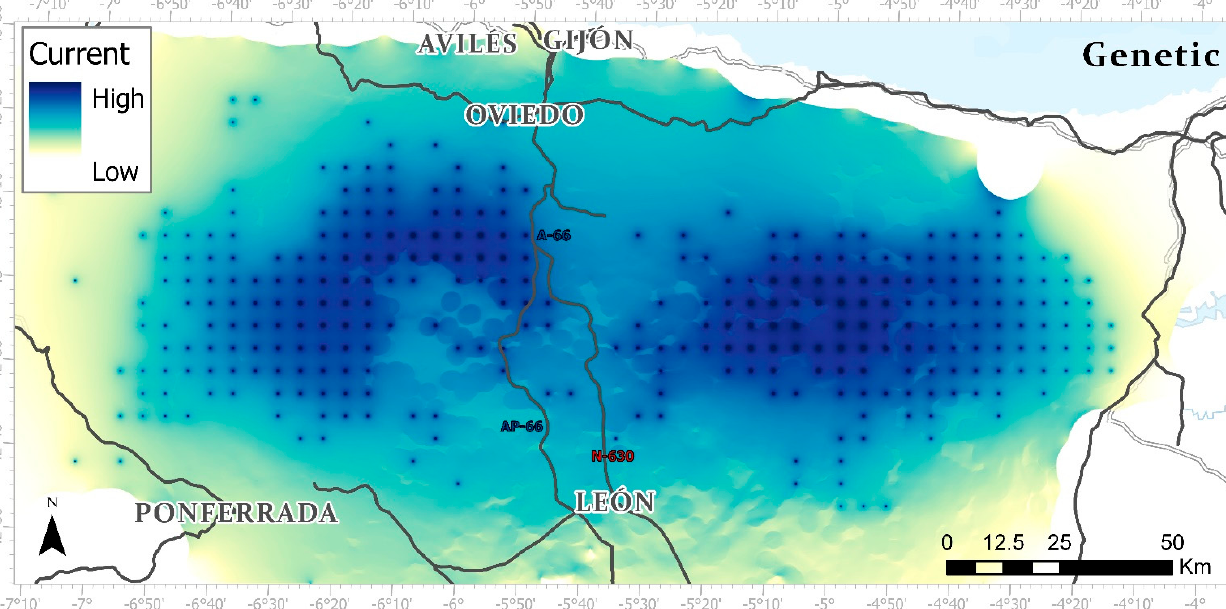
Figure A5. Current map based on the circuit theory methodology for the genetic-multiplicative resistance surface.